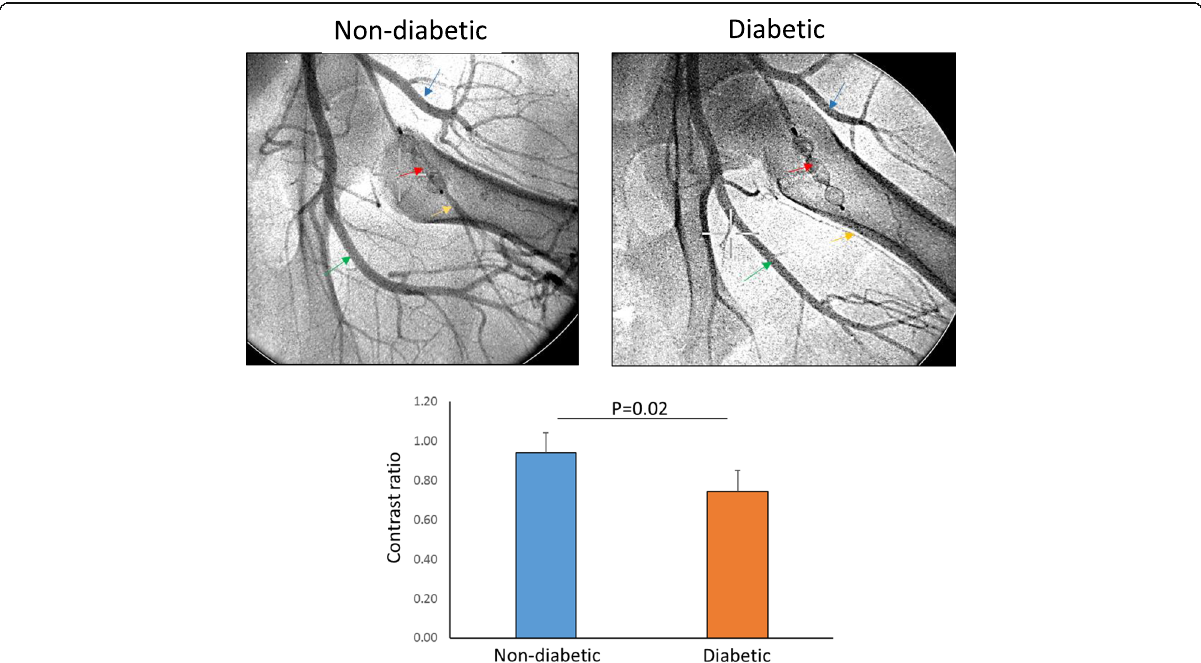
Fig. 5 Top images show contrast angiograms performed at day 28 after FAO immediately prior to sacrifice showing the occluder (red arrow) and the anterior femoral artery immediately distal to the occluder (yellow arrow). The non-diabetic pig (left) shows good contrast opacification of the vessel immediately distal to the occluder while the diabetic pig (right) shows poor opacification. The green arrow identifies the profunda artery and blue arrow the circumflex branch of the anterior femoral artery that are providing more abundant collaterals in the non-diabetic pig than the diabetic pig. The bar graph below shows mean ± SD for ratios of contrast intensity between the distal anterior femoral artery and the profunda artery for the non-diabetic and diabetic